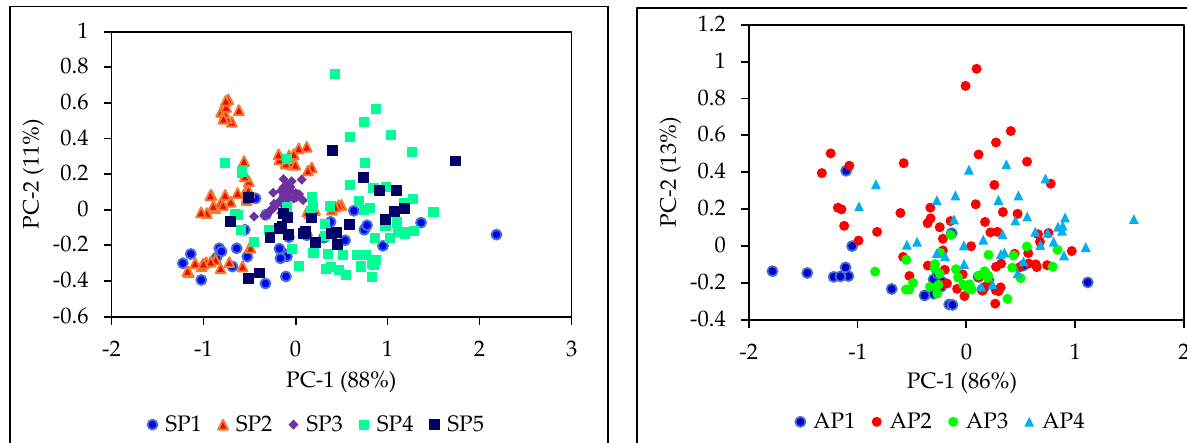
Figure 2. Principal component score plots of NIR spectra of different grain sorghum populations including starch ( left ) and amylose ( right ) data sets.